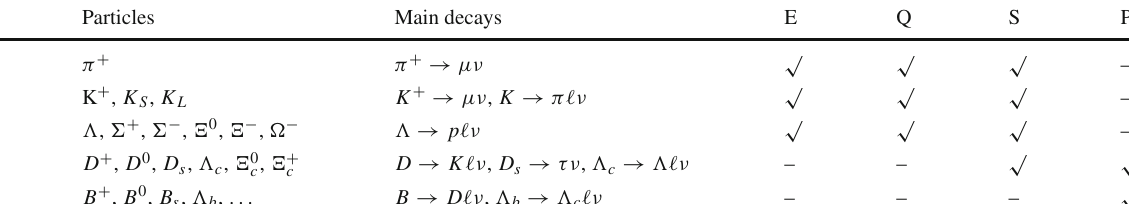
Table 1 Decays considered for the estimate of forward neutrino pro- duction.Foreachtypeinthefirstcolumn,welisttheconsideredparticles in the second column and the main decay modes contributing to neu- trino production in the third column. In the last four columns we show